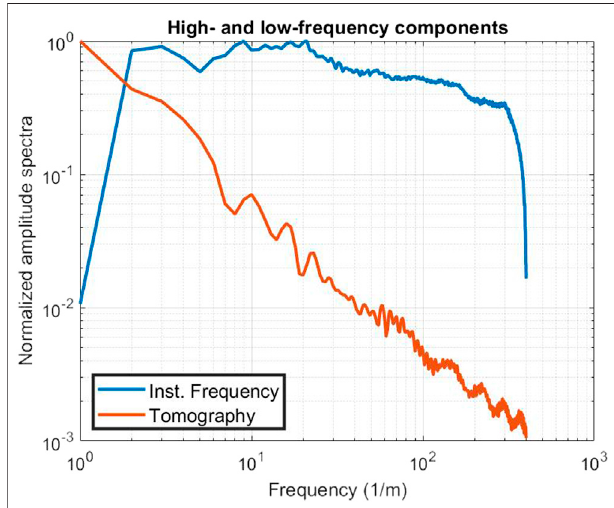
FIGURE 12 | Normalized amplitude spectra of the high- and low- frequency components of the estimated anelastic absorption, in bi- logarithmic